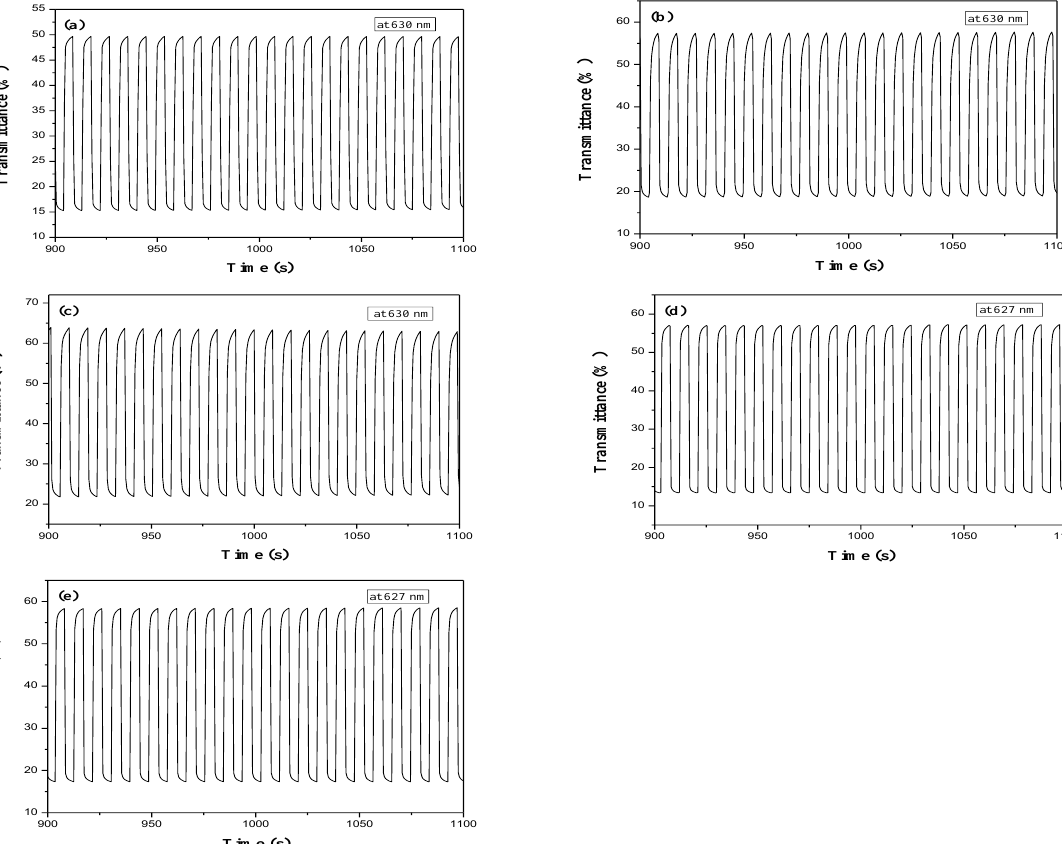
Figure 8. Optical contrast of ( a ) PDTC/PEDOT-PSS, ( b ) P(DTC- co -BTP)/PEDOT-PSS, ( c ) P(DTC- co -BTP2)/PEDOT-PSS, ( d ) P(DTC- co -TF)/PEDOT-PSS, and ( e ) P(DTC- co -TF2)/PEDOT-PSS ECDs with a residence time of 5 s. Table 6. Optical properties of devices.